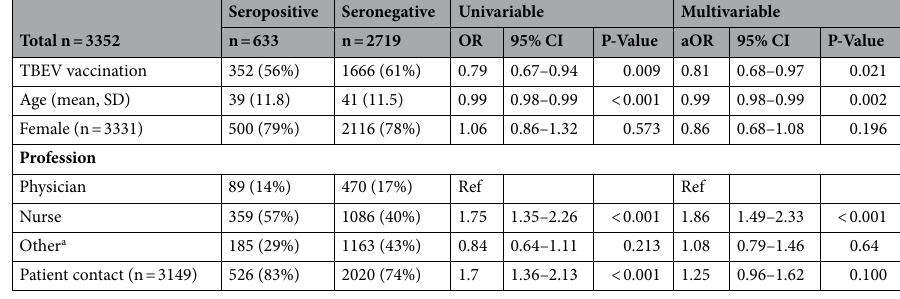
Table 1. Characteristics of SARS-CoV-2 seropositive and seronegative individuals from a prospective healthcare worker cohort and results of logistic regression analyses. a includes professions without patient contact. aOR adjusted Odds Ratio, CI Confidence Interval, Ref Reference category for logistic regression, SARS-CoV-2 Severe Acute Respiratory Syndrome Coronavirus 2, SD Standard Deviation, TBEV Tick-Borne Encephalitis Virus.